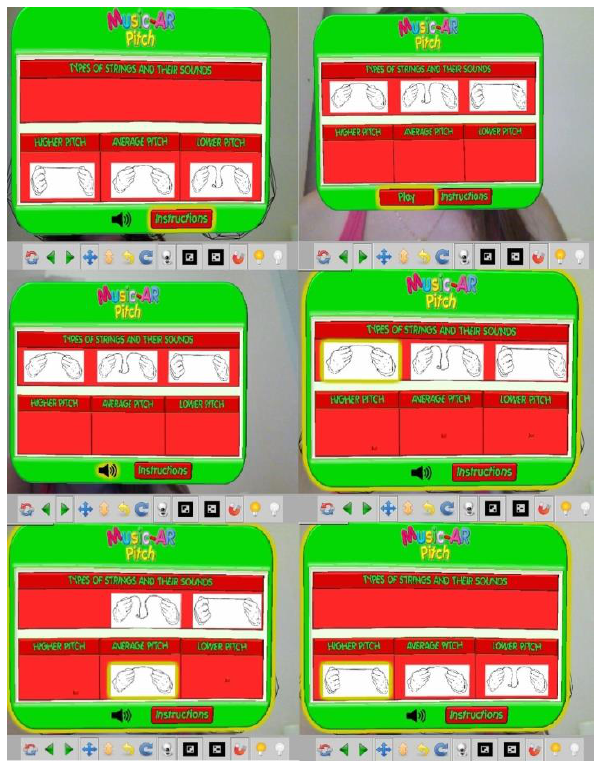
Figure 3. Main screens running the game on the